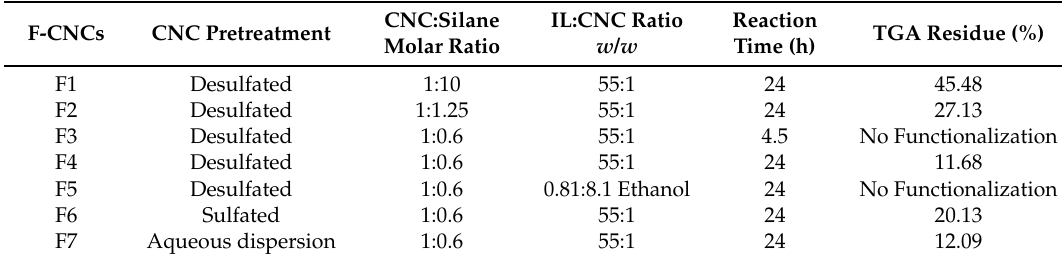
Table 2. Reaction conditions of functionalization of CNCs in choline lactate ionic liquid.